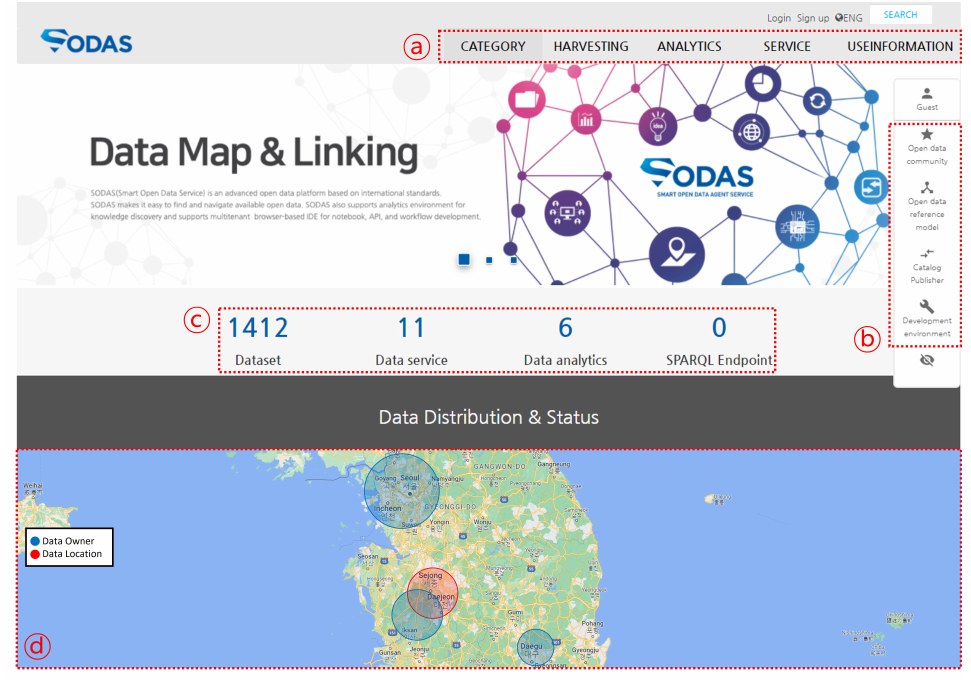
Figure 11. Main screen of SODAS data portal.